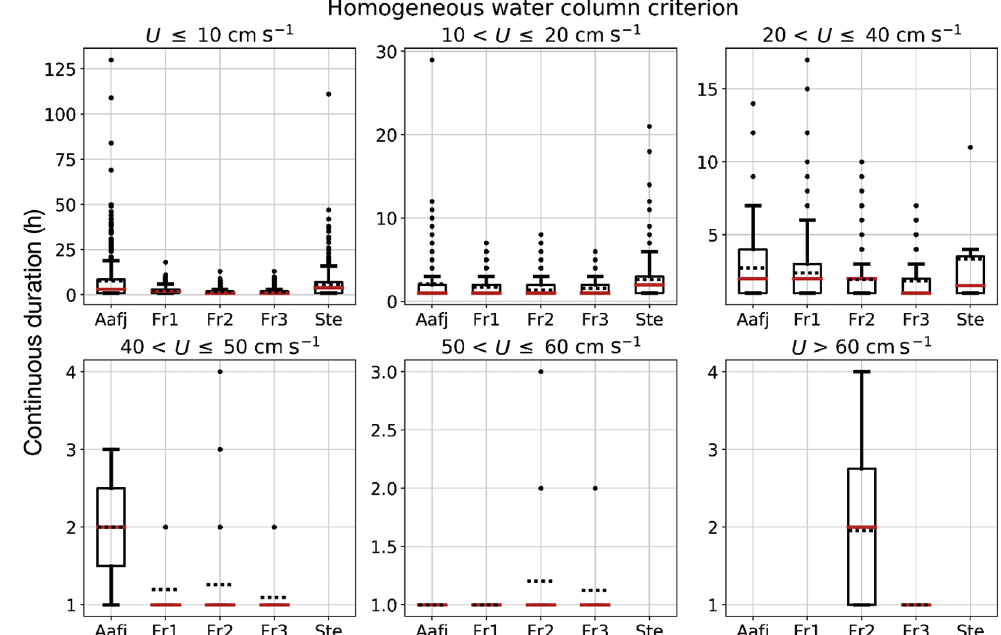
Fig. 5. Number of consecutive hours in each current class using the homogeneous criterion for the water column. Red line: median; horizontal dotted line: mean. Lower whisker extends to first quartile (Q1) minus 1.5 times the interquartile range (IQR). Upper whisker extends to the third quartile (Q3) plus 1.5 × IQR. Data outside of the whiskers are events that exceed Q3 + 1.5 × IQR. These are represented as dots and are considered valid data points. Dots may overlap; hence dots do not necessarily represent a single occurrence. Note the different y -axes. U : current speed. See Fig. 1 for site